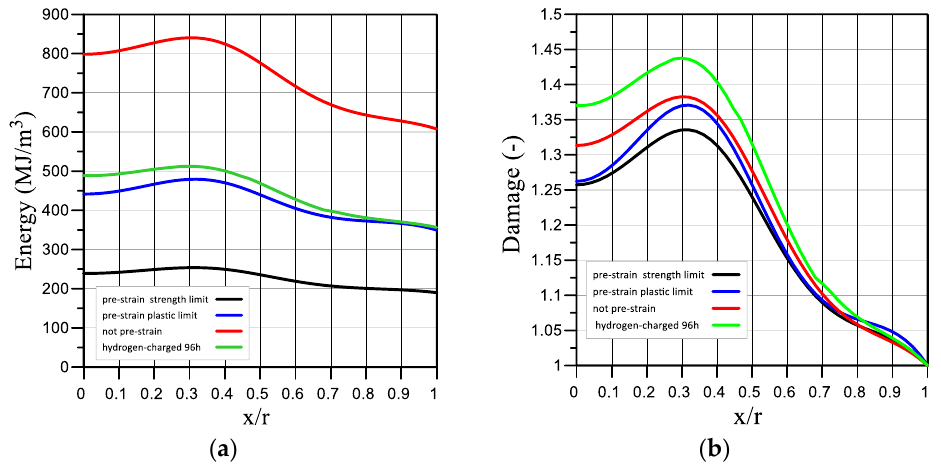
Figure 11. The critical value distribution of strain energy ( a ) and the damage parameter ( b ) in the sample under four load modes: not pre-strained — I mode (red), pre-strained to the yield strength — II mode (blue), pre-strained to the ultimate strength — III mode (black), pre-hydrogenated — VI mode (green).